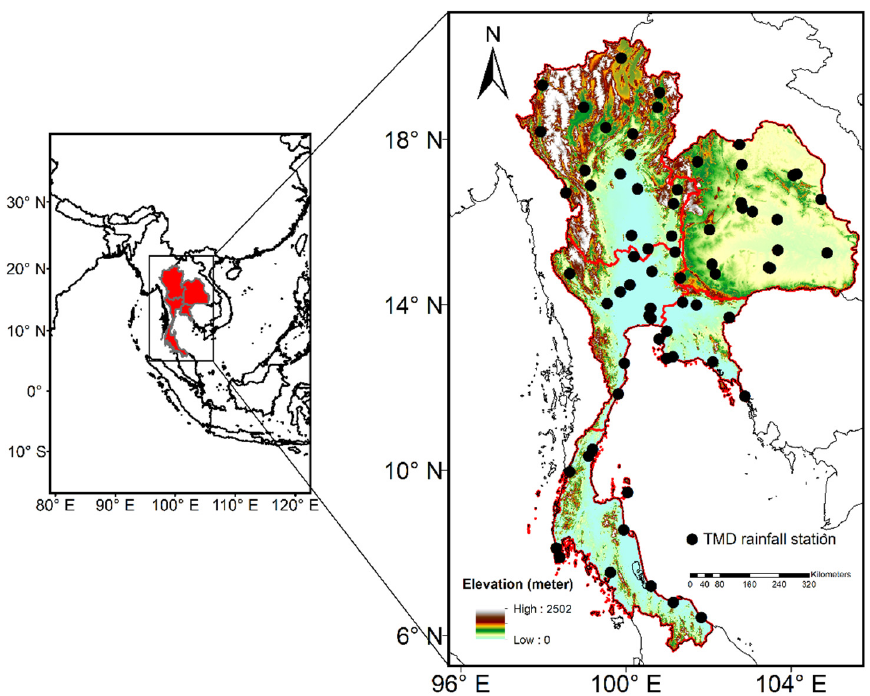
Figure 1. Spatial distribution of the Thai Meteorological Department’s rainfall stations (black dots) used in this study. The red line represents the border of Thailand and its five sub ‐ regions (i.e., the North, Northeast, Central, East, and South), superimposed on the terrain elevation obtained from the 30 ‐ m Shuttle Radar Topography Mission (SRTM) elevation data.